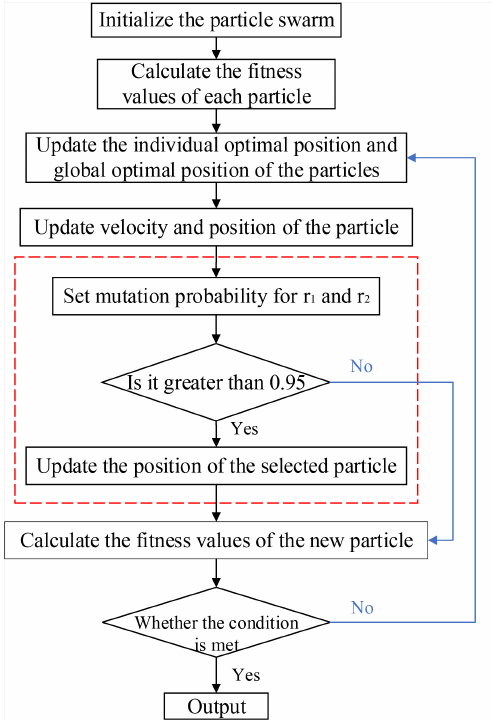
Figure 8. The flowchart of particle swarm optimization based on adaptive